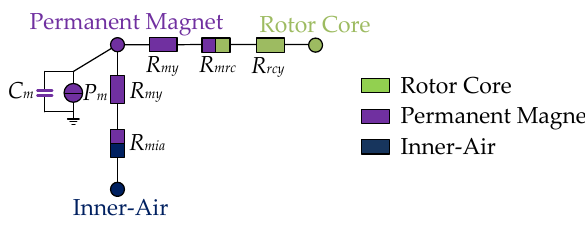
Figure 11. Thermal model of the permanent magnet.